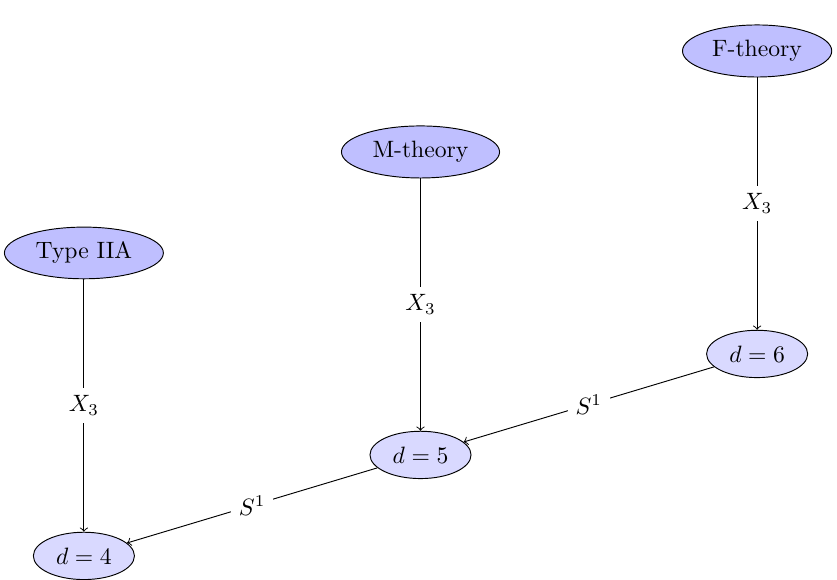
Figure 1 . The various theories under consideration and their interconnections. (In the case of F-theory, the data of the (cid:12)bration X 3 B 2 | when it exists | is used to specify the type IIB ! axio-dilaton.) Each lower-dimensional e(cid:11)ective theory has eight Poincar(cid:19)e